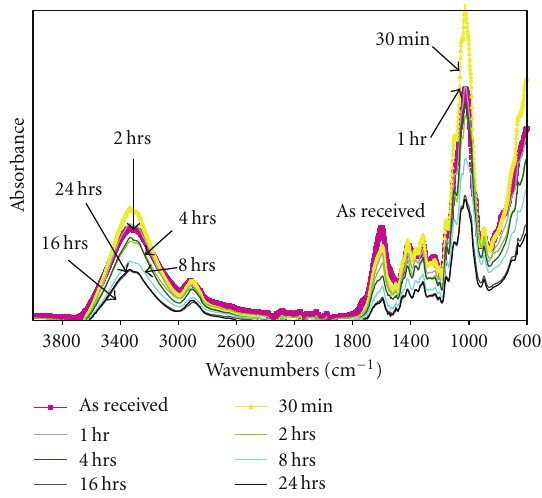
Figure 6: E ff ect of alkali treatment on surface functionality of kenaf